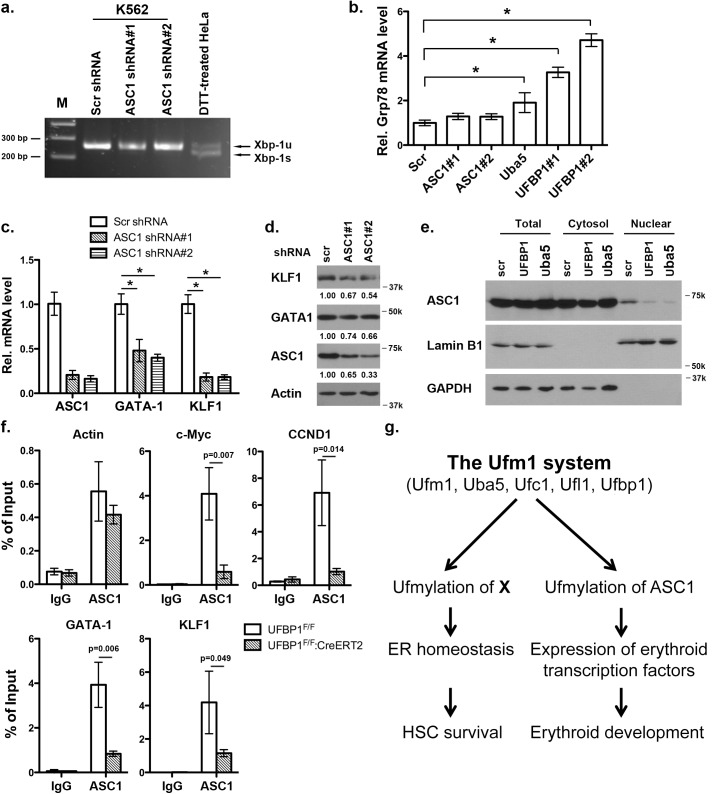
Knockdown of ASC1 down-regulates expression of erythroid transcription factors but does not activate the UPR.
a.
Xbp-1 mRNA splicing in ASC1-depleted K562 cells. mRNA from DTT (dithiothreitol)-treated HeLa cells was used as a positive control. b. Expression of Grp78 in K562 cells with knockdown of ASC1, Uba5 and UFBP1. The data are presented as the relative level to K562 cells treated with scrambled shRNA. * p < 0.01 (n = 3). c. Expression of GATA-1 and Klf1 in ASC1-knockdown K562 cells. The data are presented as the relative level to the cells with scrambled shRNA. * p < 0.01 (n = 3). d. GATA-1 and KLF1 protein level in ASC1 knockdown cells. e. Subcellular localization of ASC1 in UFBP1 and Uba5 knockdown K562 cells. Subcellular fractionation of K562 cells was performed according to [6]. Lamin B1 was used as the nuclear marker, while GAPDH was used as the cytosolic marker. f. ChIP analysis of ASC1 association to the promoters of GATA-1 and Klf1 genes in BM cells. BM and spleen cells were isolated from phenylhydrazine-treated control and UFBP1 CKO mice, and subjected to ChIP assays. c-Myc and CCND1 promoters were used as positive ASC1 targets while actin promoter was the negative control. Data are presented as means ± SD (n = 3). g. A working model for the role of ufmylation in regulation of hematopoiesis.